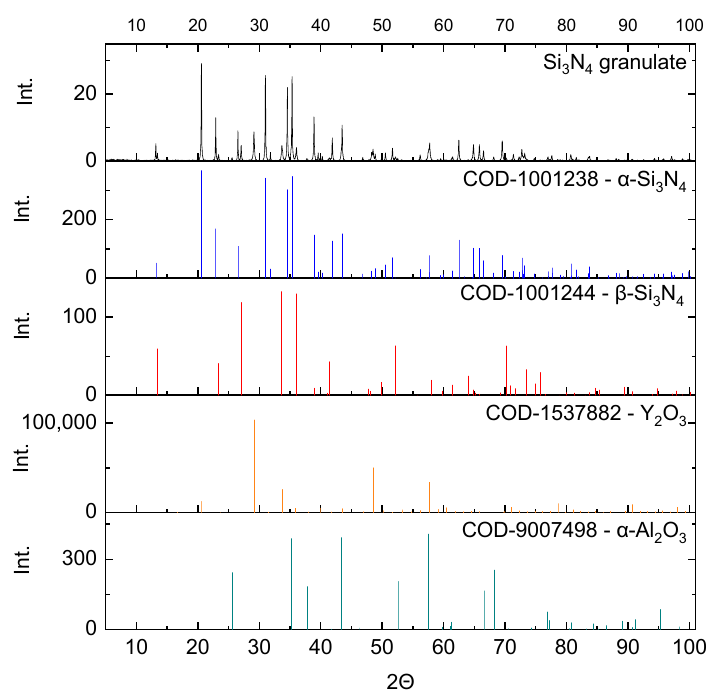
Figure 2. Diffractogram of the Si 3 N 4 granulate used in the research and the intensity of the characteristic reflections of phases present in the sample.